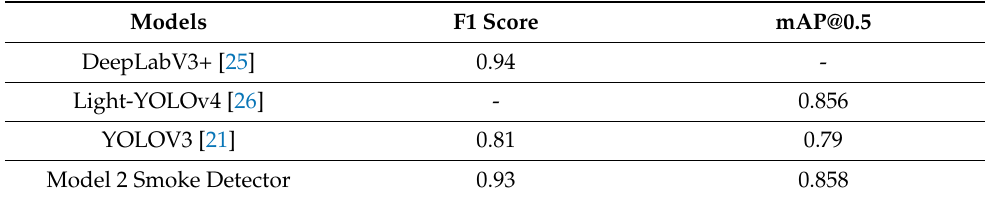
( b ) Figure 8. Two-stage results: smoke detection combined with fire detection ((a): model 1 and (b) model 2) . From the start, our goal was to build a good functional and usable model, and also, we think that detecting smoke is more important than fire due to the possibility to prevent fire from escalating. We can see better detection results with the two-stage detection with more coverage of the smoke. Two-stage detection combined with the classifier ensemble has a promising result due to the fast response of the YOLOv5 model. In addition, we intend to implement a